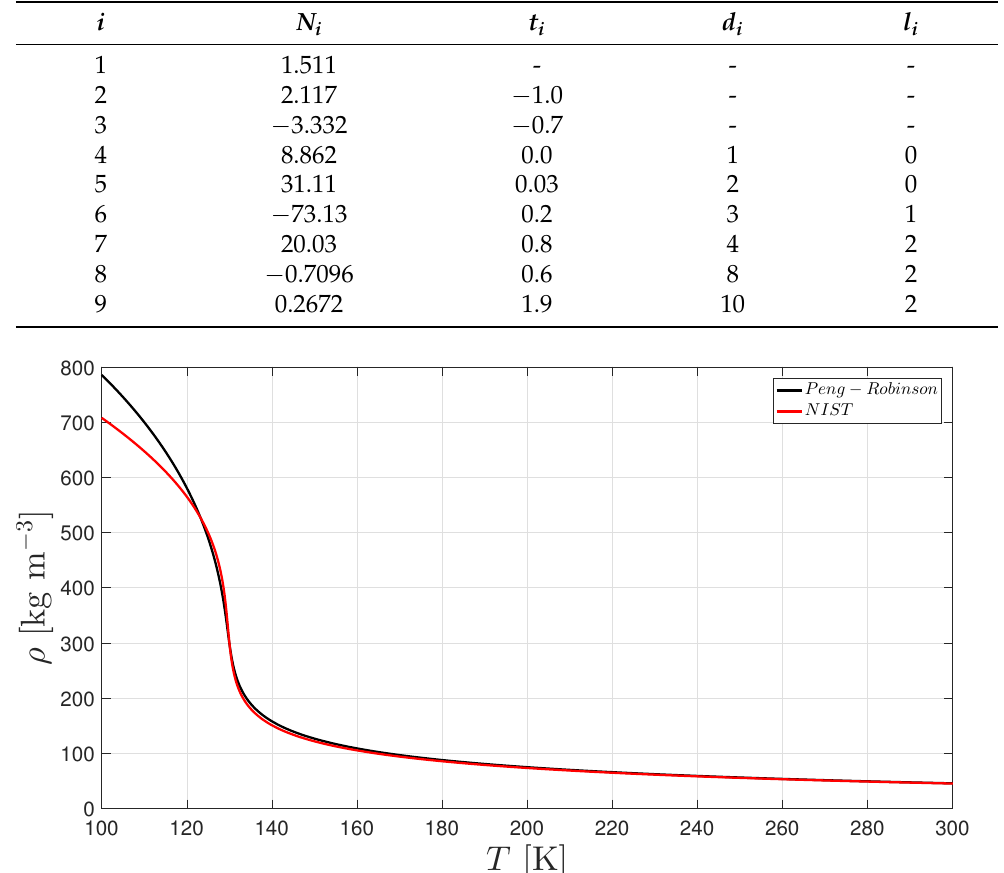
Table 4. Nitrogen coefficients and exponents of the residual fluid thermal conductivity equations [57].